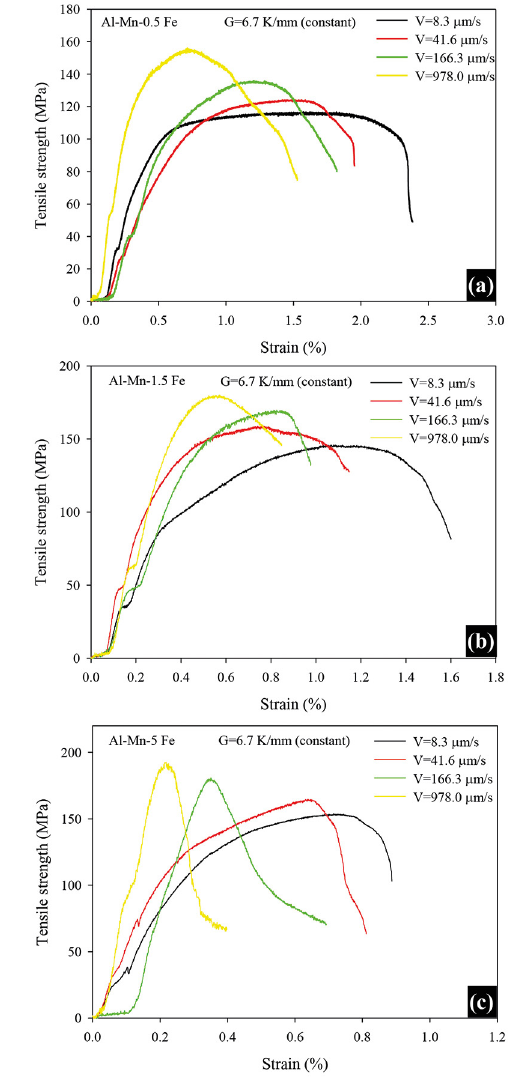
Fig. 9 Typical tensile strength-strain curves of Al–1.9Mn–xFe alloys for different V at a constant G (a) Al–1.9Mn–0.5Fe (b) Al–1.9Mn–1.5Fe (c)